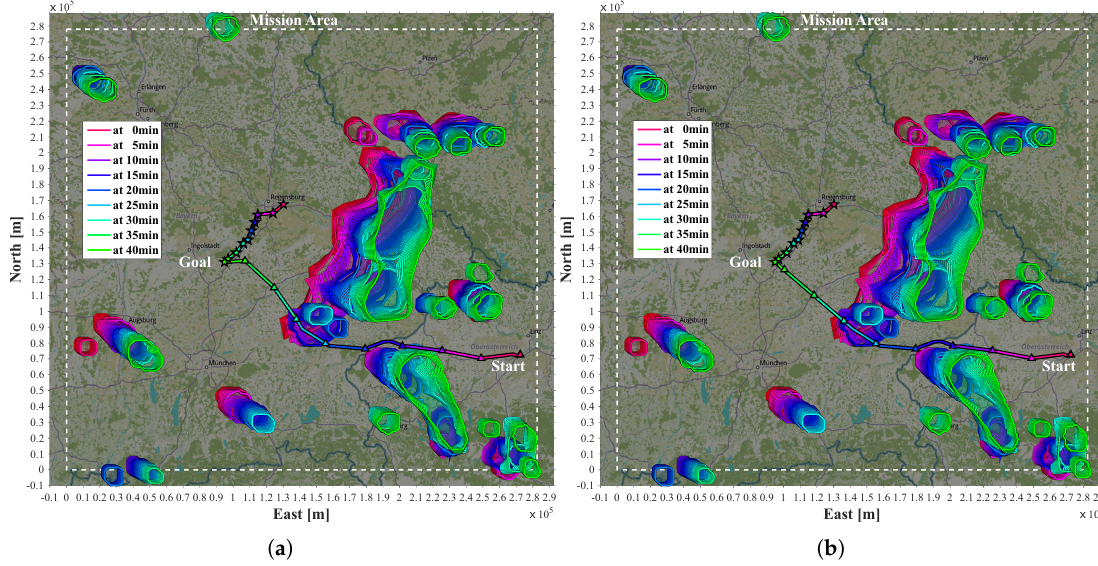
Figure 15. ( a ) Reactive trajectory and ( b ) anticipatory trajectory to a moving